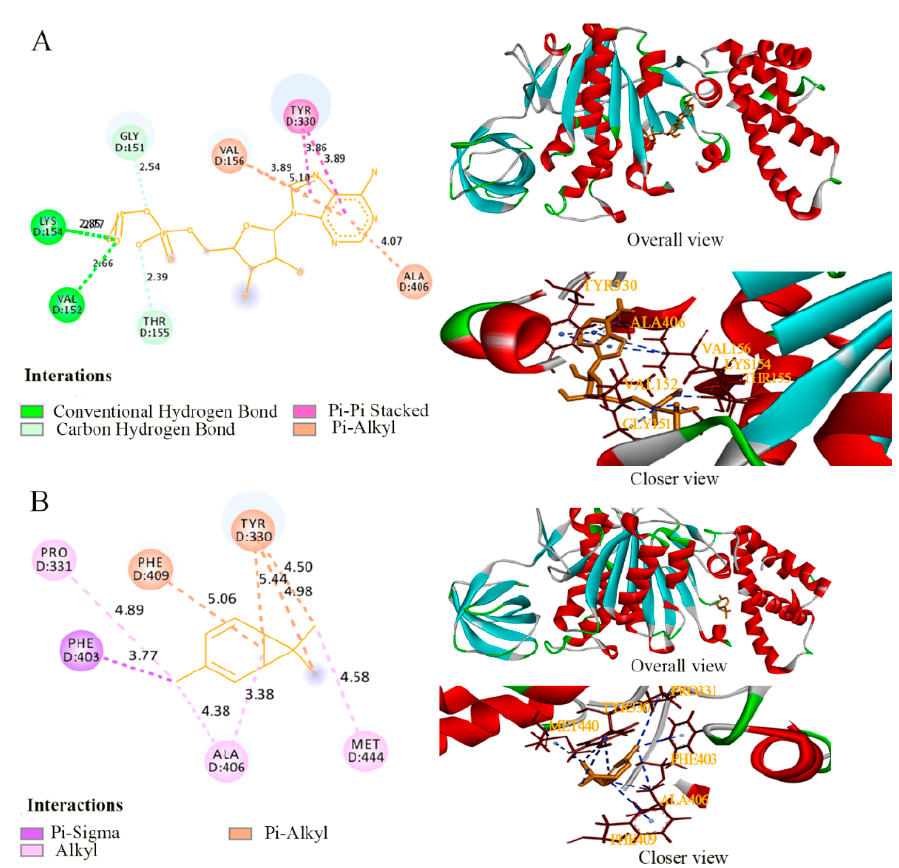
Figure 9. The binding details of AtpD with adenosine diphosphate (ADP) ( A ) and 3-carene ( B ).